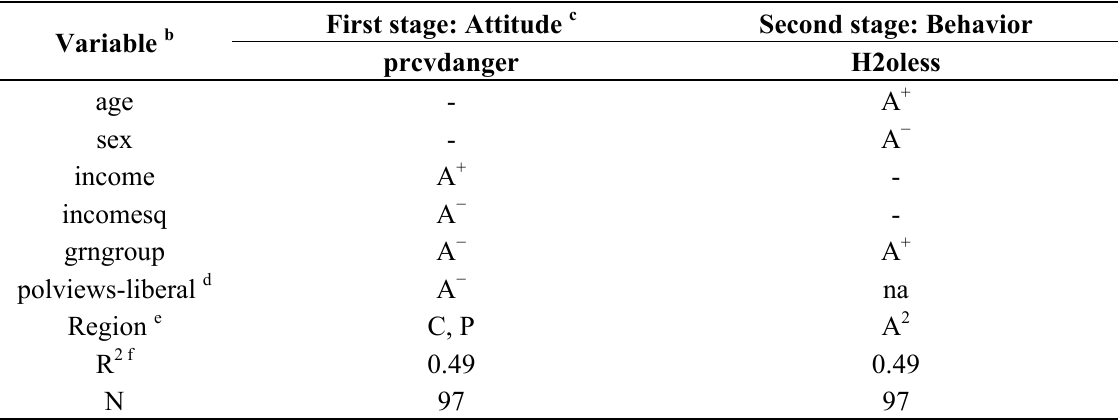
Table 4. CS1: WSA models for which variable is significant at p ≤ 0.05 a . Variable